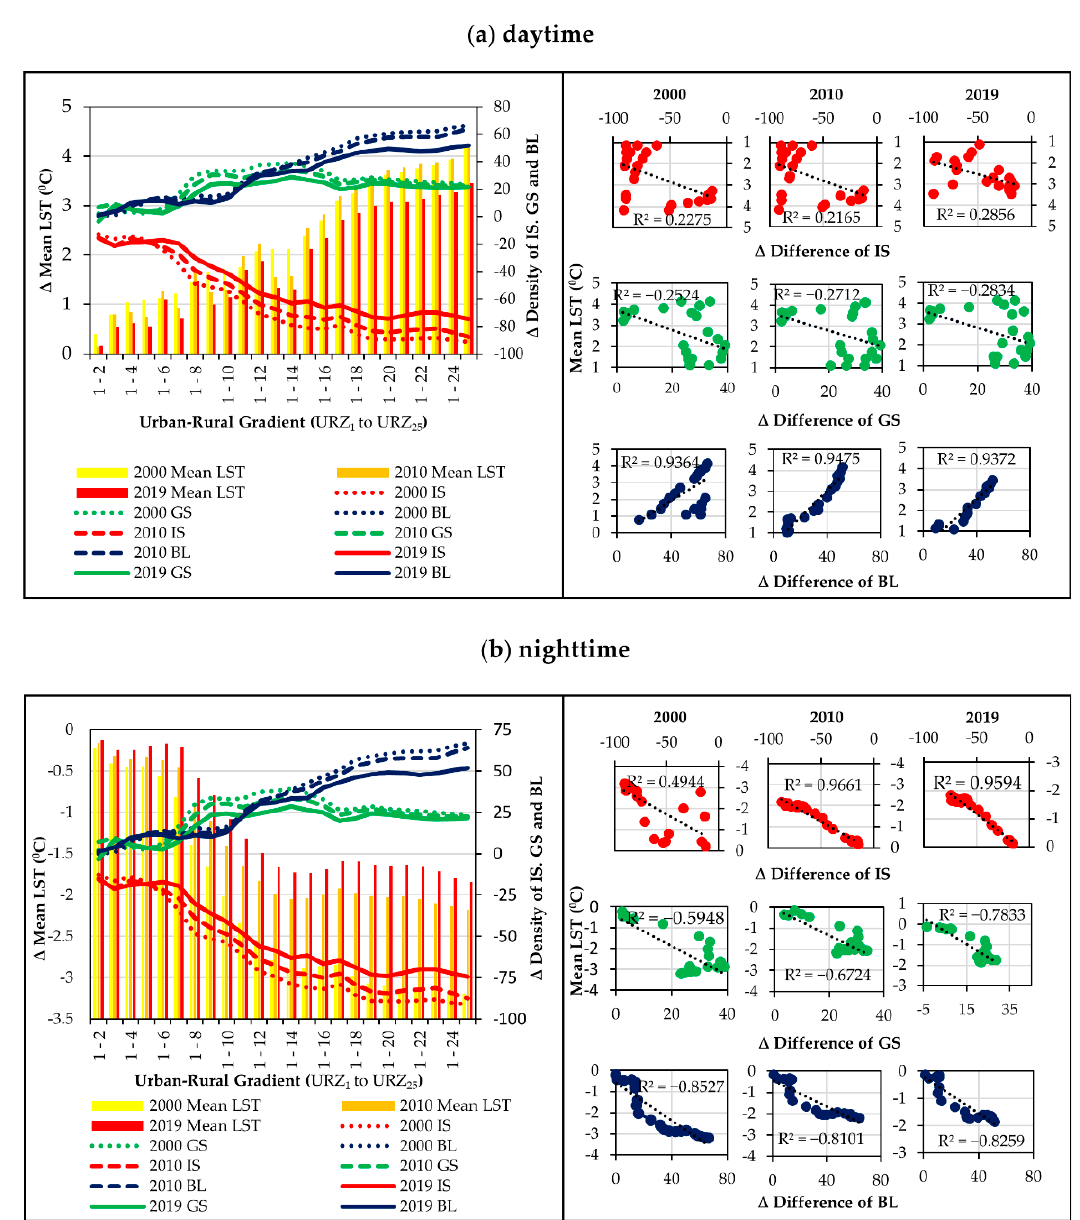
Figure 8. The magnitude and trend of surface urban heat island (UHI) intensity (2000–2019): ( a ) daytime surface UHI intensity and statistical relationships and ( b ) nighttime surface UHI intensity and statistical